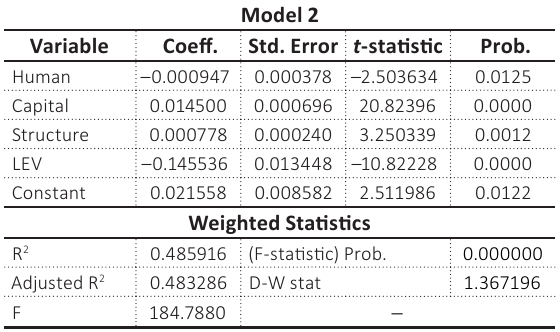
Table 11. Random effect